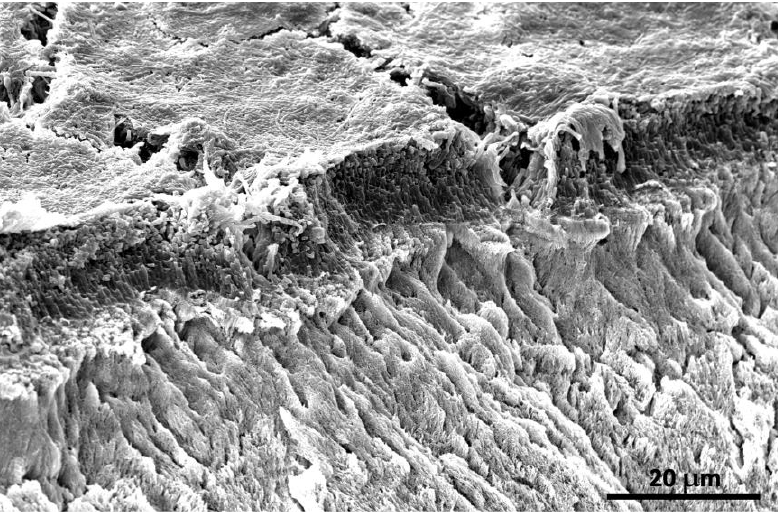
Figure 1. Scanning electron microscopy (SEM) shows the adhesion of oral biofilm to the enamel Figure surface.